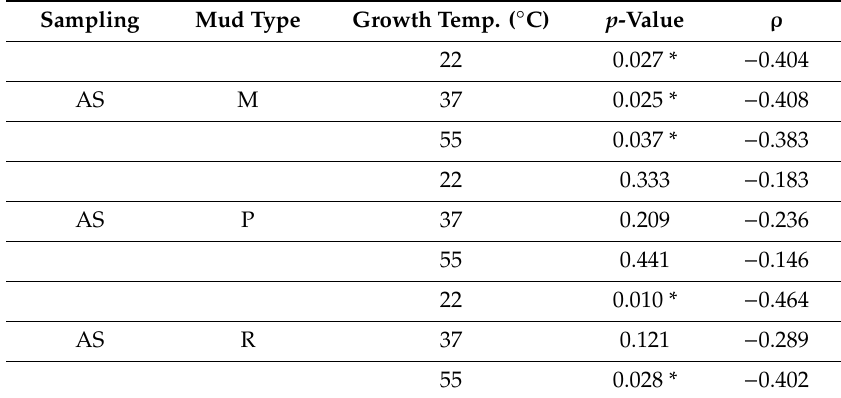
Table 9. Correlation between thermal water temperature and TVCs of AS mud samples. The table provides p -values and ρ coe ffi cients for Spearman’s R test. Significant p -values ( < 0.05) are marked with asterisk (*). AS—autumn sampling; M—maturing mud, P—peloid, R—regenerating used mud.